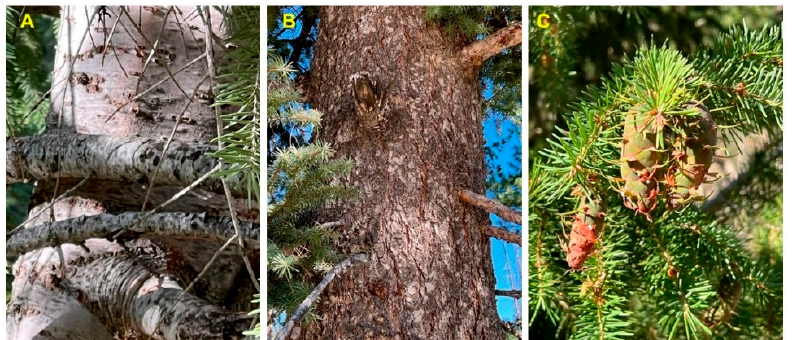
Figure 8. Pseudotsuga menziesii var. glauca from southern Idaho. ( A ): bark of young tree. ( B ): bark of old tree. ( C ): leaves and cones. Photographs by K. Swor.